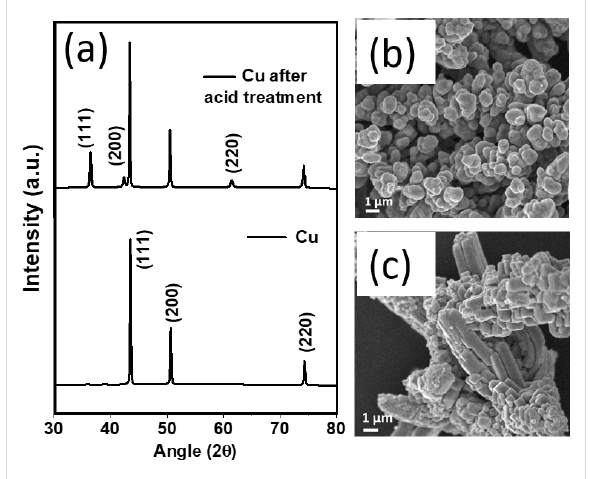
Figure 1: (a) XRD patterns of commercially available Cu powder and Cu powder after treatment with 0.5 M HNO 3 . (b) SEM images of pure Cu powder and (c) acid-treated Cu